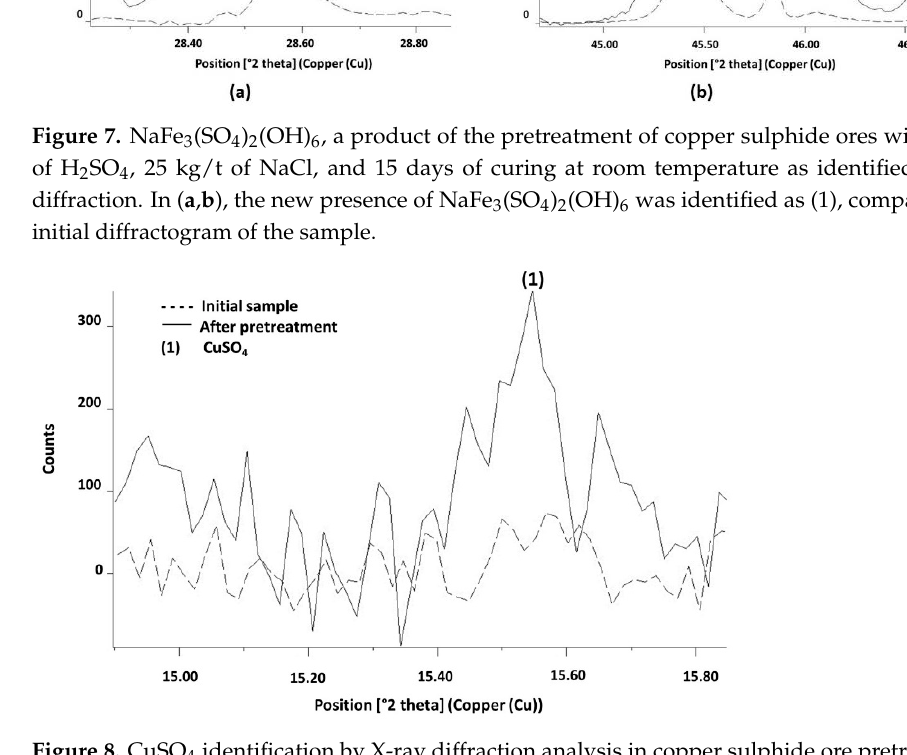
Figure 8. CuSO 4 identification by X-ray diffraction analysis in copper sulphide ore pretreated with 15kg/t of H 2 SO 4 , 25 kg/t of NaCl, and 15 days of curing at room temperature.